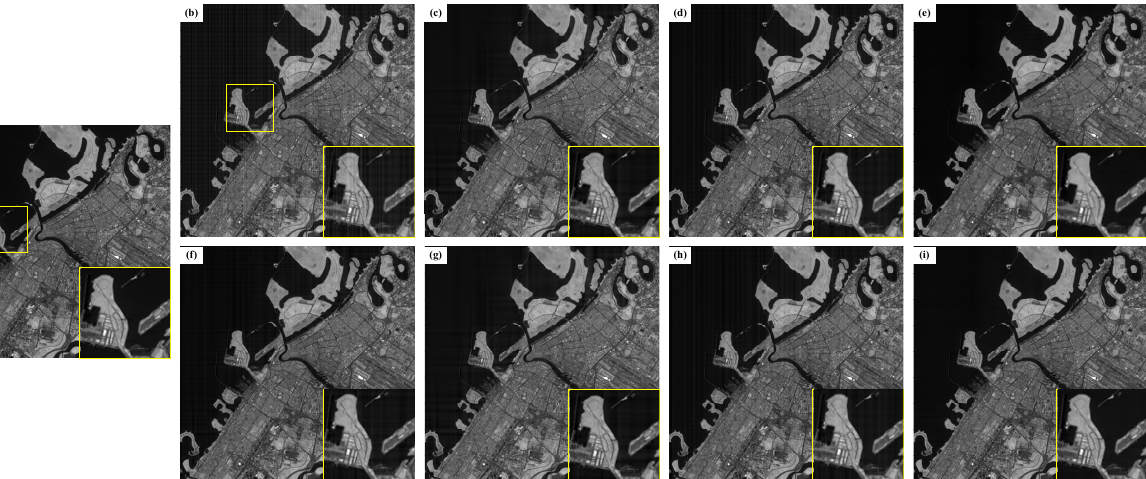
Figure 3. Comparison of simulation image processing results: ( a ) noiseless, ( b ) add fringe noise, ( c ) GF, ( d ) A ‐ Contrario, ( e ) LRSID, ( f ) FSG, ( g )GF + FSG, ( h ) A ‐ Contrario + FSG, ( i ) Ours.